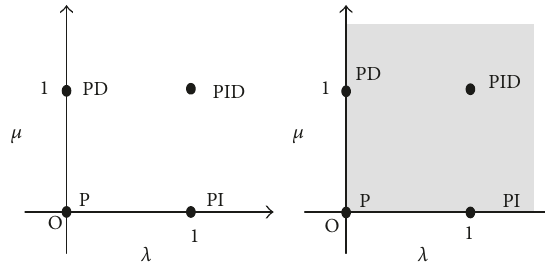
Figure 8: Comparison of PID and FOPID